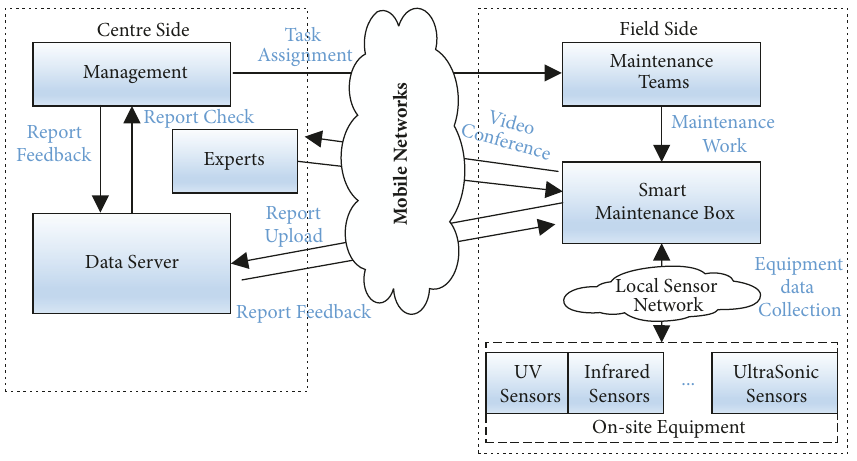
Figure 1: Architecture of the proposed system.